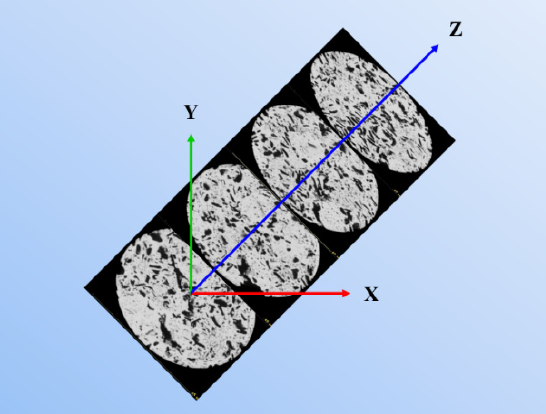
Figure 4. Illustration of cross sections along the Z axis for the cylindrical test samples.